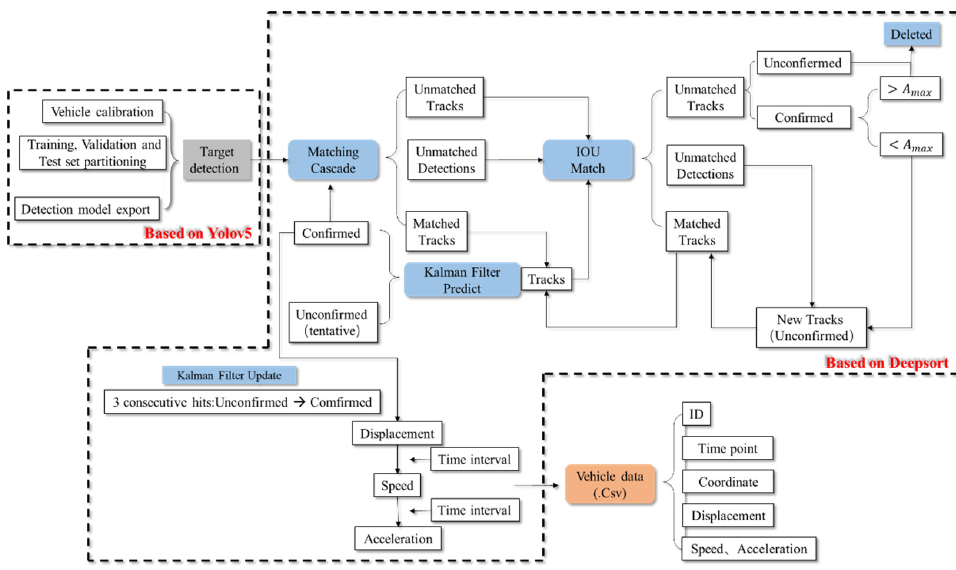
Figure 10. Continuous vehicle tracking process using DeepSORT algorithm. After the detection and continuous tracking of the vehicle target are completed, as shown in Figure 11, the time interval and calibration parameters obtained in Section 4.2.1 can be used to collect information such as speed and acceleration.